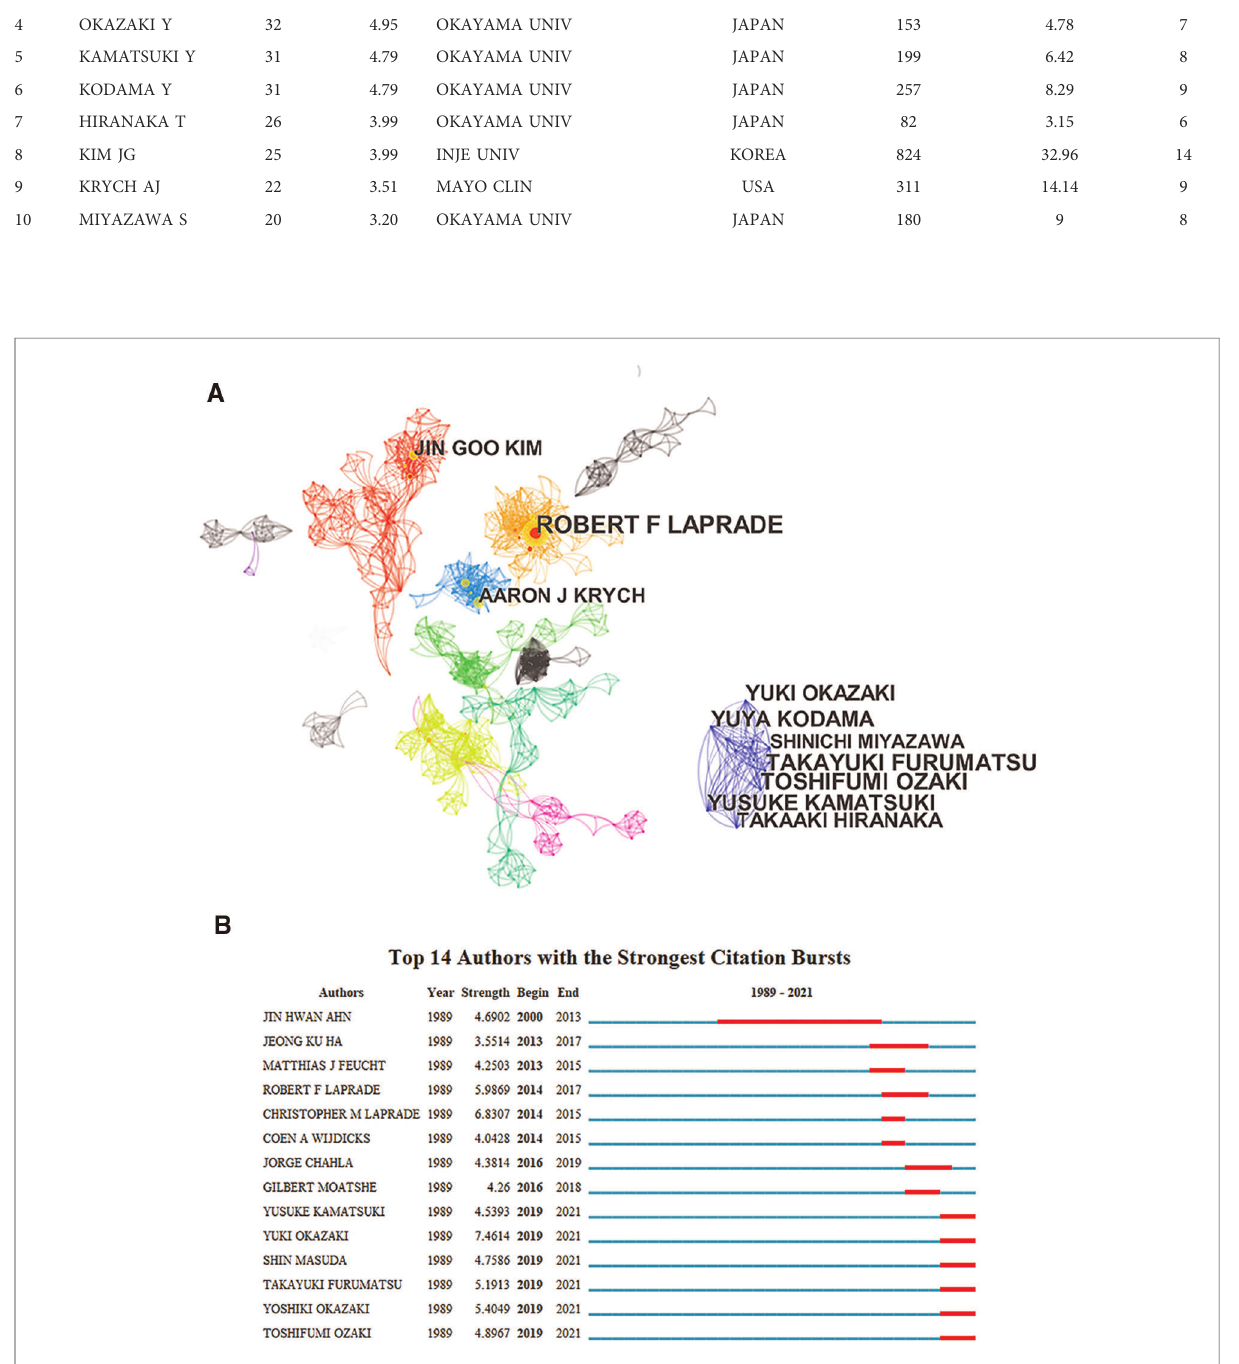
FIGURE 4 The collaboration network among authors for tear of meniscal root tears research. ( A ) The clusters of cooperation network of authors ( B ) The strongest citation bursts of